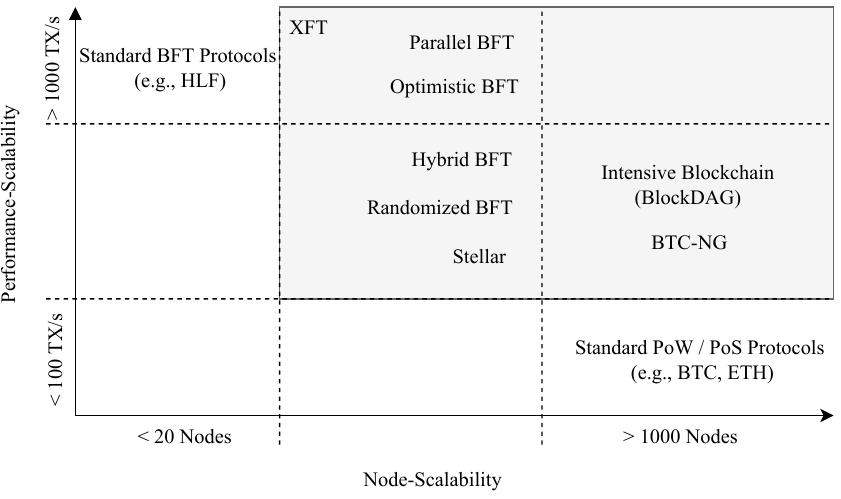
Figure 10. Scalability comparison between ETH, BTC, HLF, and other technologies still in